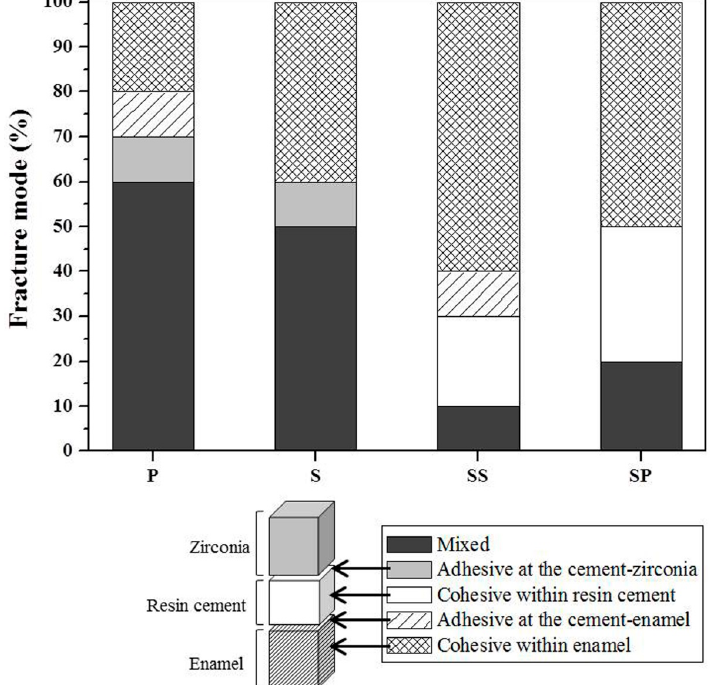
Figure 3. Percentages (%) of the fracture mode after tensile bond strength test of enamel bonded to 3Y-TZP. P: Polishing; S: Sandblasting; SS: Sandblasting + SIE technique; SP: Sandblasting + MDP-containing silane primer.